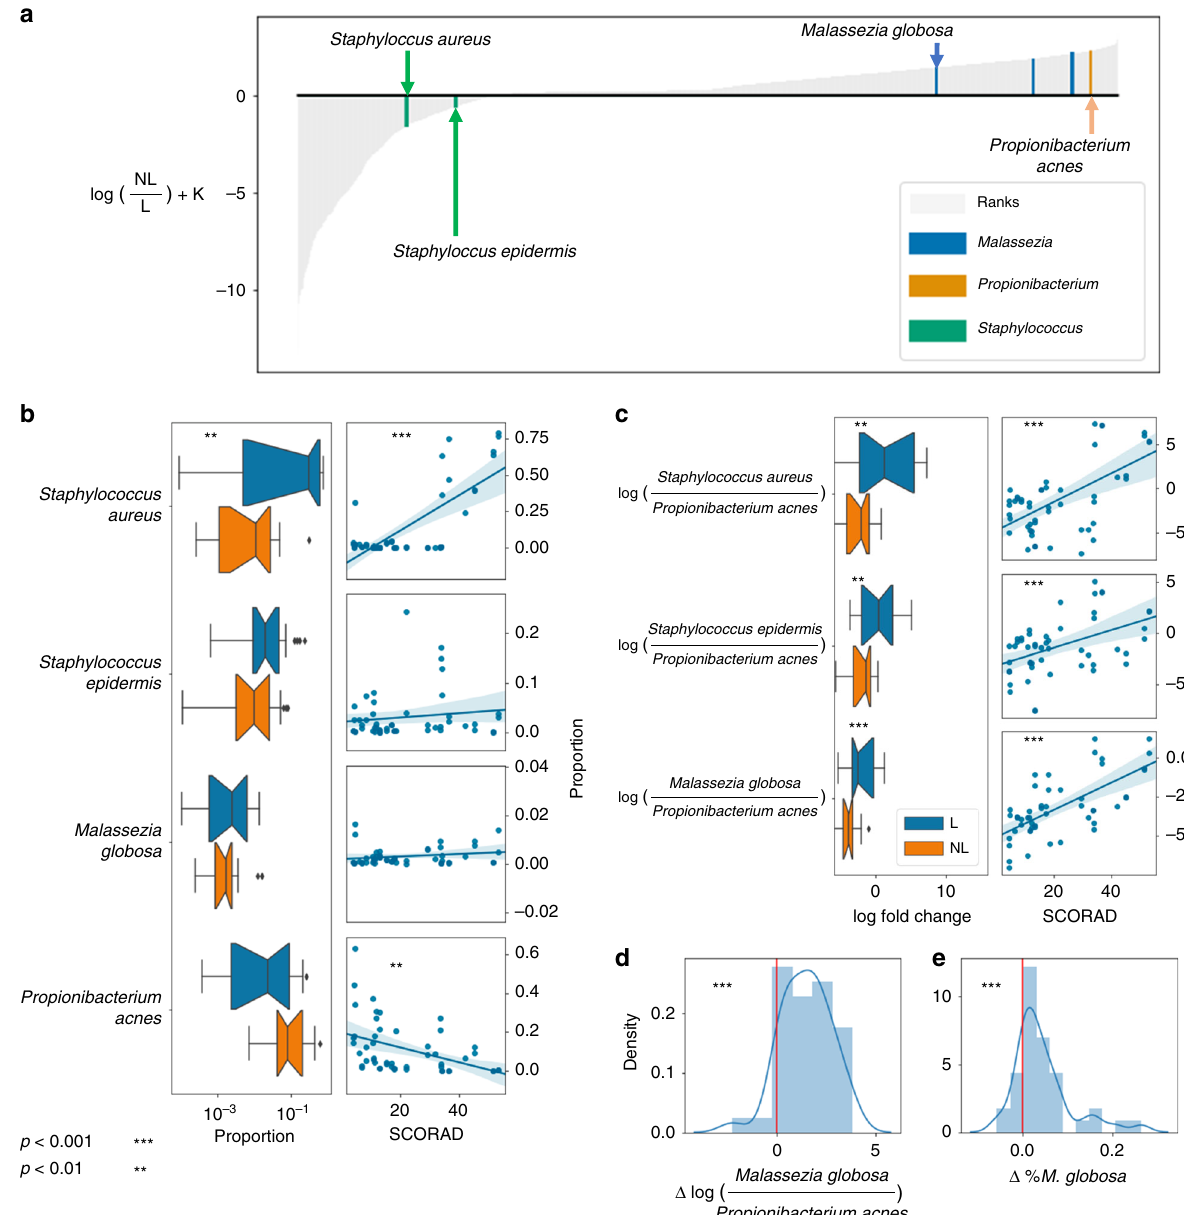
Fig. 3 DR analysis of skin in two atopic dermatitis studies. Panels a – c represent data from Byrd et al. 27 , and panels d , e represent data from Leung et al. 28 . Both studies compare lesioned (L) to non-lesioned (NL) skin. a Microbial ranks estimated from multinomial regression applied to shotgun metagenomics from Byrd et al. 27 with key genera highlighted. The y -axis represents the log-fold change that is known up to some bias constant K. b Proportions of S. aureus , S. epidermidis , M. globosa , and P. acnes in lesioned (blue) and non-lesioned (orange) skin (left) and correlation of relative abundance with SCORAD score (right). c Log-ratios of ( S. aureus: P. acnes ), ( S. epidermidis: P. acnes ), and ( M. globosa: P. acnes ) (left) and correlation of ratio with SCORAD score (right). Error bars represent standard deviation across participants ( n = 20). d Change in log-ratio of ( M. globosa: P. acnes ) from Leung et al. 28 . e Change in relative abundance of M. globosa between lesioned and non-lesioned skin from Leung et al. 28 . Presented p -values are from paired t -test